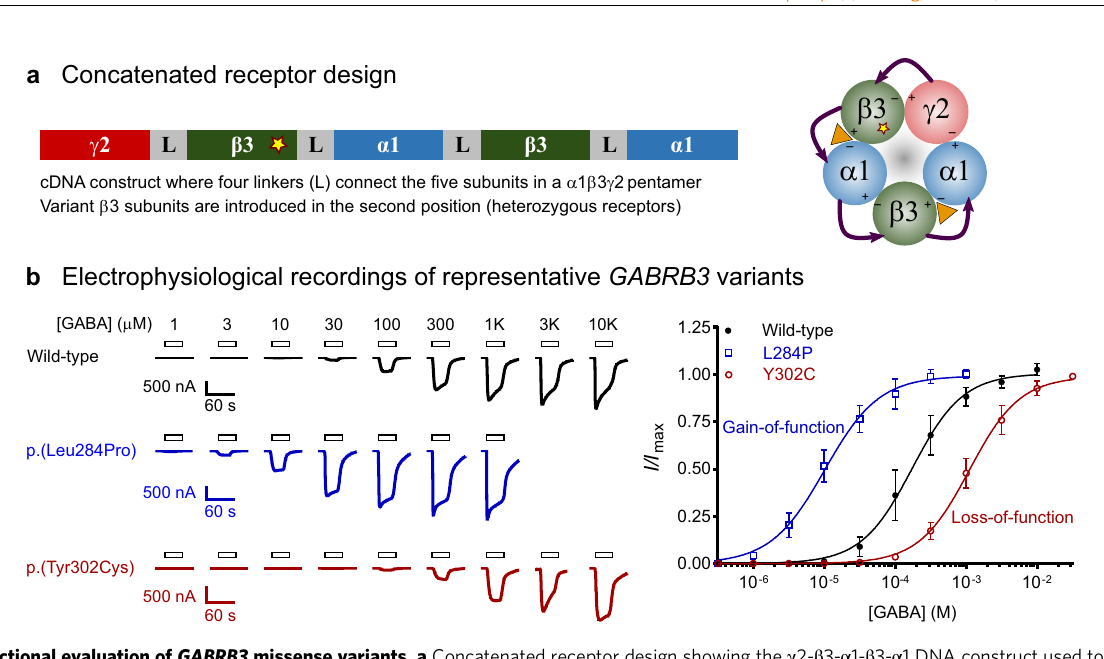
Fig. 2 Functional evaluation of GABRB3 missense variants. a Concatenated receptor design showing the γ 2- β 3- α 1- β 3- α 1 DNA construct used to introduce single missense variants. A pentameric receptor that arranges with a single β 3 variant (star) is depicted. b Raw electrophysiological recordings and concentration – response curves at selected concatenated γ 2- β 3- α 1- β 3- α 1 wild-type (black), p.(Leu284Pro) (blue) and p.(Tyr302Cys) (red) β 3 variant receptors that represent a gain-of-function and a loss-of-function variant, respectively. Bars indicate GABA applications and scale bars for each trace are shown. Peak current amplitudes were measured at each GABA concentration and a Hill equation was fi tted to the data. Thereafter the dataset was normalized to its respective maximum current amplitude for each cell. Black circles (wild-type, n = 12 independent cells), blue open squares (p.(Leu284Pro), n = 12) and red open circles (p.(Tyr302Cys), n = 12) represent the mean ± s.d ( n ≥ 12) and the lines represent the fi tted Hill equation at each receptor. Gain- of-function variants shift the concentration – response curve to the left, loss-of-function to the right. Source data are provided in the Source Data fi